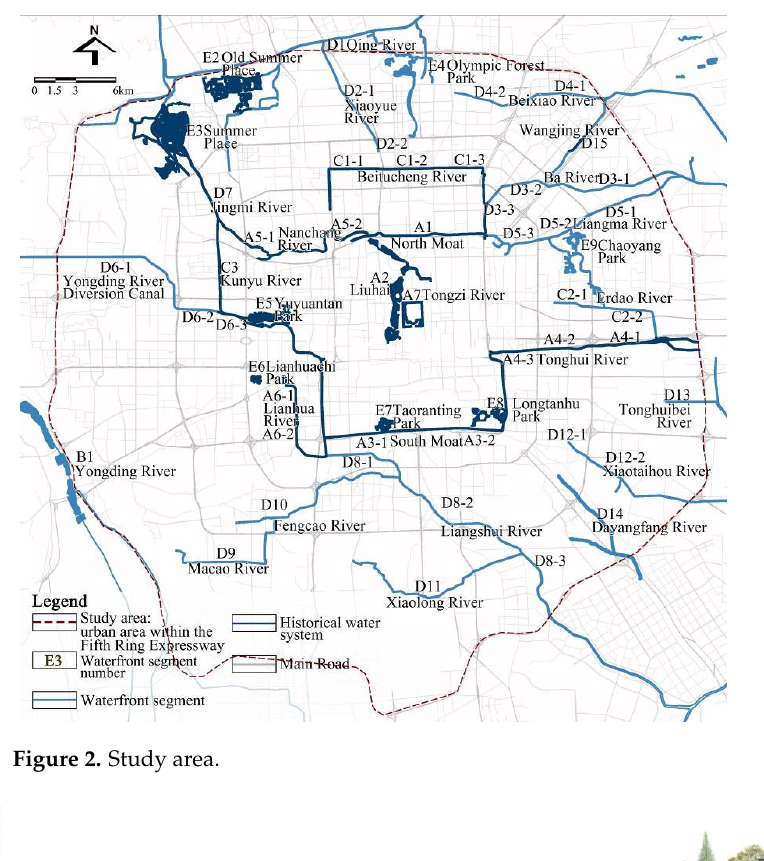
Figure 2. Study area.